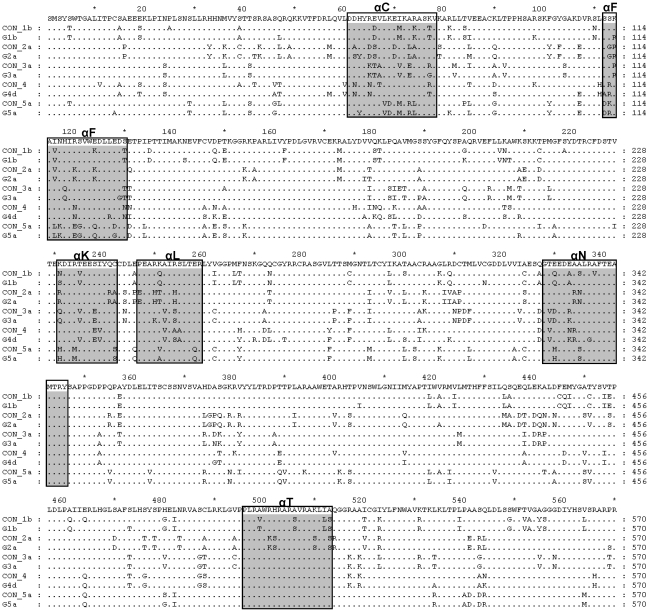
Amino acid sequences of the isolates used in this study.Alignment of the predicted amino acid sequences (Δ21) of the NS5B proteins used in this study and the consensus sequences corresponding to subtypes 1b, 2a, 3a and 5a. As only 1 sequence for subtype 4d was present in the http://hcv.lanl.gov/the consensus for NS5BΔ-4d corresponds to the whole genotype 4. Only differences with a general consensus sequence are shown. Gray boxes indicate the sequences corresponding to αhelixes C, F, K, L, and N.